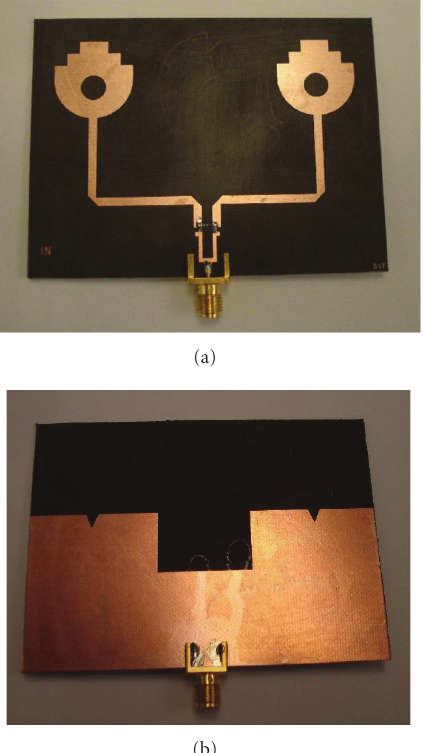
Figure 11: Fabricated two-element UWB linear antenna array with corporate feed, (a) top view and (b) bottom view.